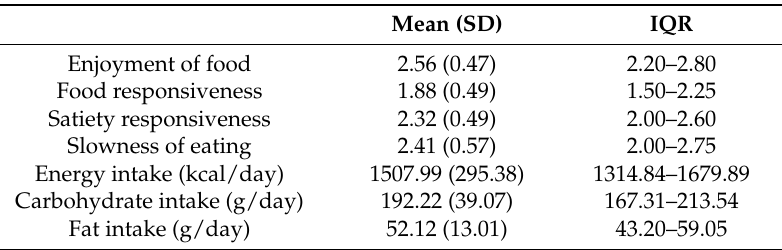
Table 2. Mean values outcome measures.